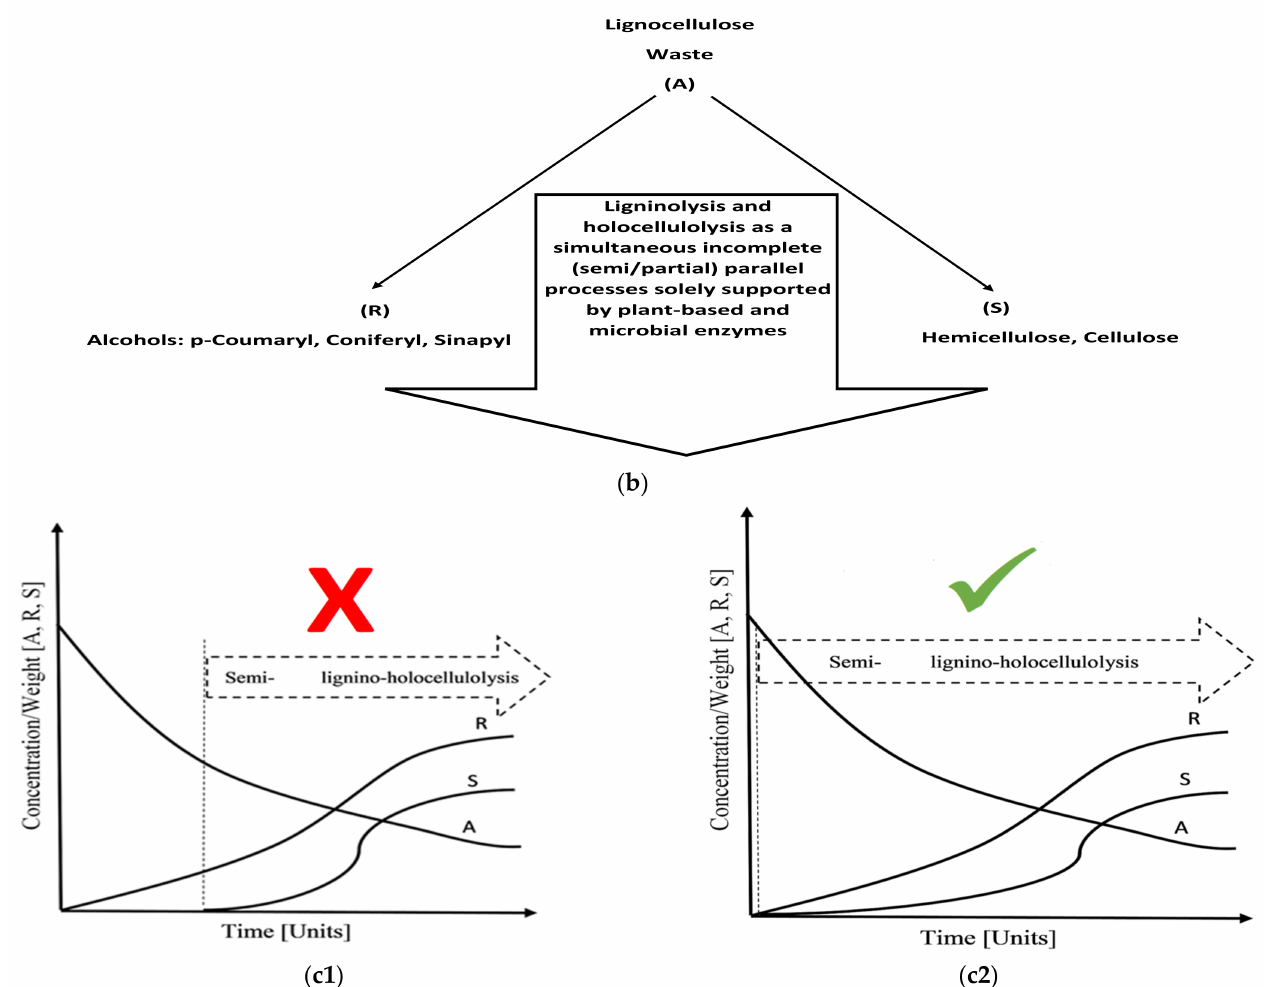
Figure 2. ( a ) Illustration of the rigid and amorphous regions of lignocellulosic waste and how plant-based or microbial enzymes will facilitate semi-lignino-holocellulolysis; ( b ) depiction of the hydrolysis of lignocellulose waste (A) into primary products, R (alcohols)-for ligninolysis and S (cellulose/hemicellulose) for holocellulolysis simultaneously; ( c1 ) demonstra- tion of semi-lignino-holocellulolysis as irreversible reactions in series; and ( c2 ) demonstration of simultaneous semi-lignino- holocellulolysis as irreversible first order reactions in